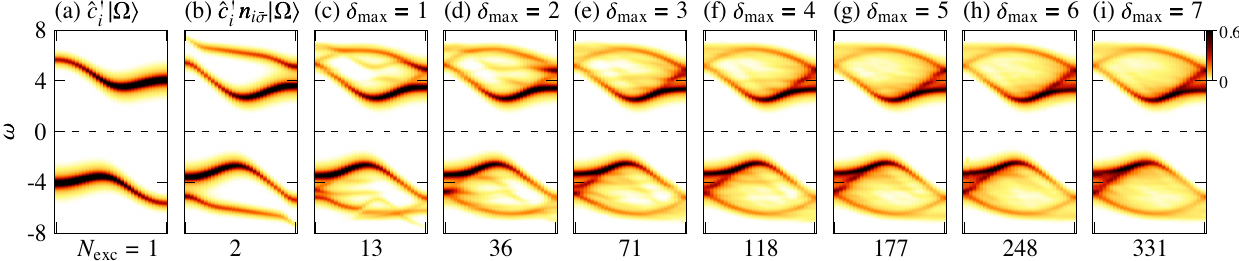
8 . Here, we show the result for max ¼